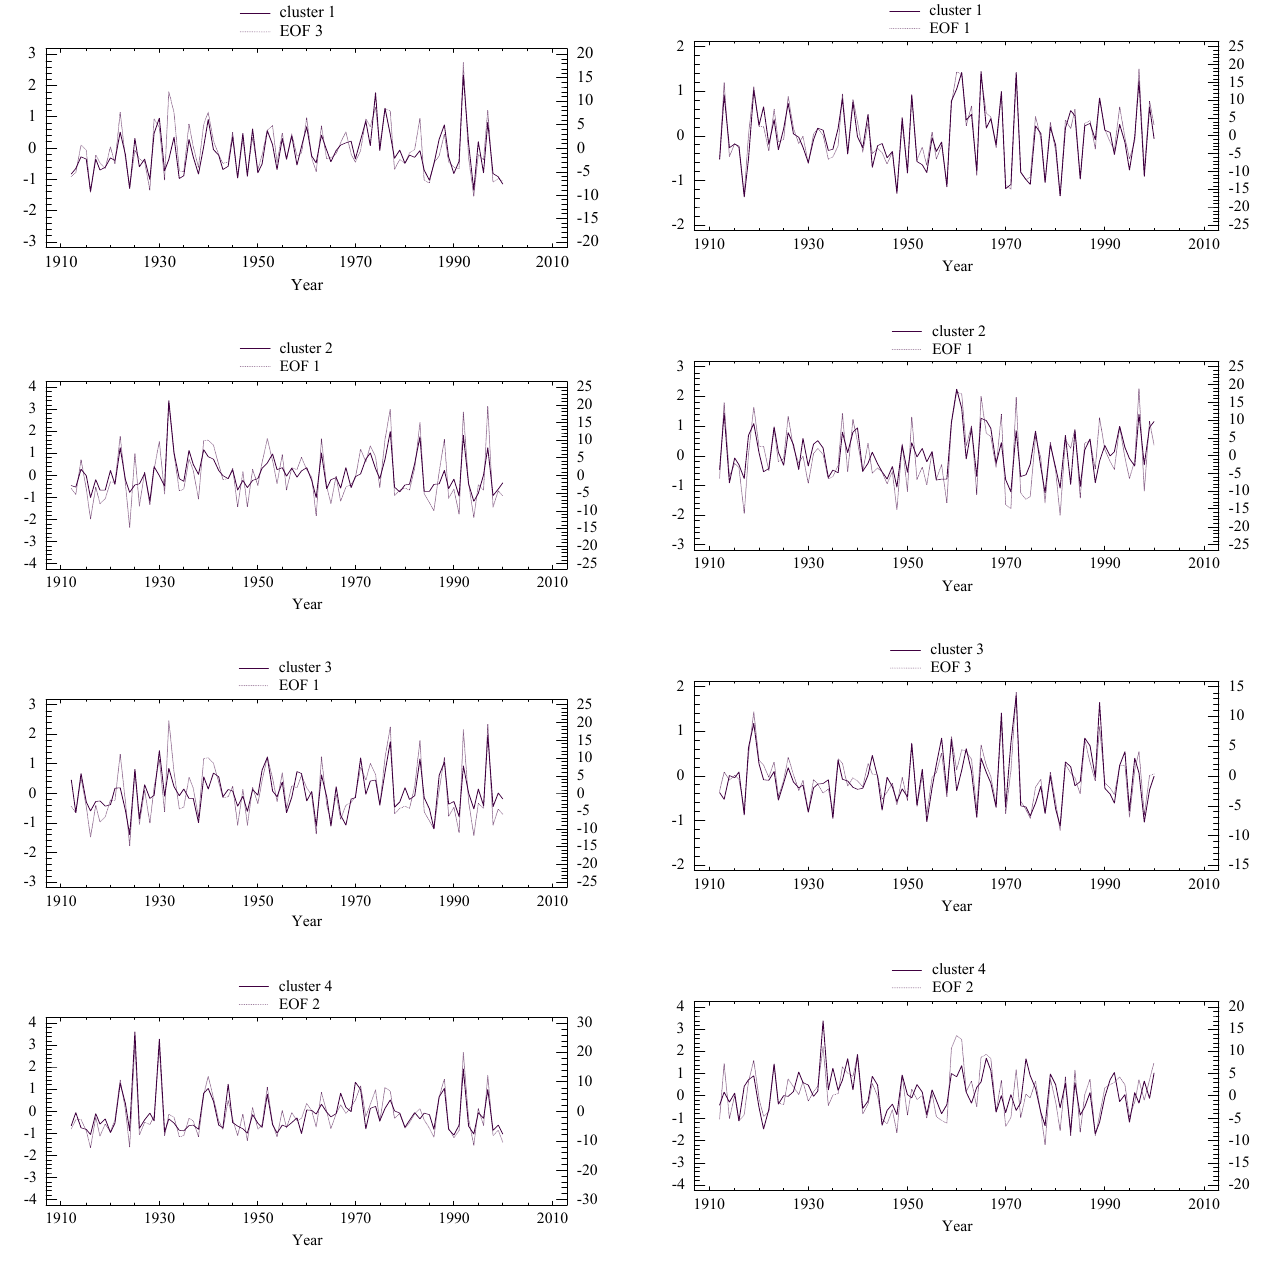
around 1960 for the Mediterranean region (C2, EOF2). In spring (Fig. 11), a prolonged dry period began around 1970 for the western (C1, EOF1) and Mediterranean (C2, EOF3) regions, and another dry period is detected from approxi- mately 1935 to 1955 for northern region (C3, EOF2). Wet peaks can be seen around 1945 for western (C1, EOF1) and Mediterranean (C2, EOF3) areas. In summer (Fig. 12), a season normally dry, wet peaks are detected around 1930 for northern (C2, EOF1, and C3, EOF1) and southwest (C4, EOF2) areas, and around 1975 for Mediterranean regions (C1, EOF3 and C2, EOF1). Finally, in autumn (Fig. 13)